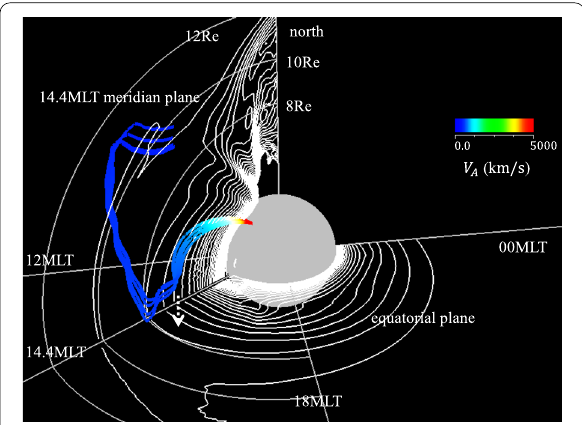
Fig. 16 Type H and L current systems at t 5.5 min colored Fig. 15 Distributions of V A in the 14.4 MLT meridian plane and the = according to inertia 3 values in the same manner as in Fig. 3. The equatorial plane. The type L current system that flows in the 14.4 MLT current lines are shown only in the area of β <0.2. The contour line plane is also shown. The white dotted arrow indicates the L value of colors change in increments of ± 0.2 . The type L current from A H is the field line where FPC is converted to FAC ( L 7). The color of the ≈ not shown in this figure. The inset in the left-bottom corner shows current lines denotes V A an enlarged part of the footpoints of both current systems. The color scale of inertia 3 for the inset is in increments of ±